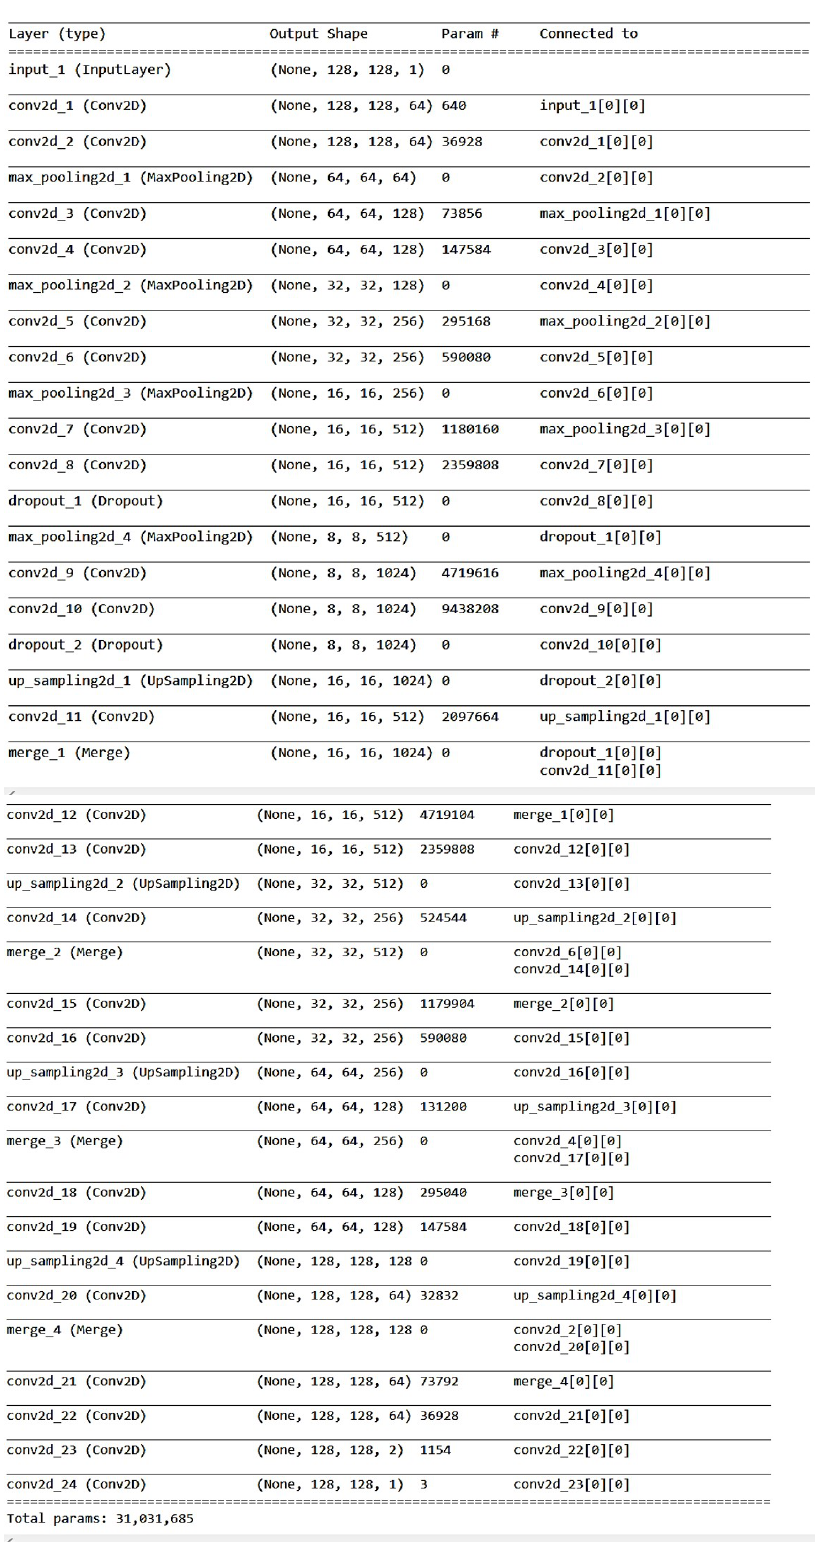
Figure 8. TensorFlow definition of the 2D U-Net used three times in the 2.5D